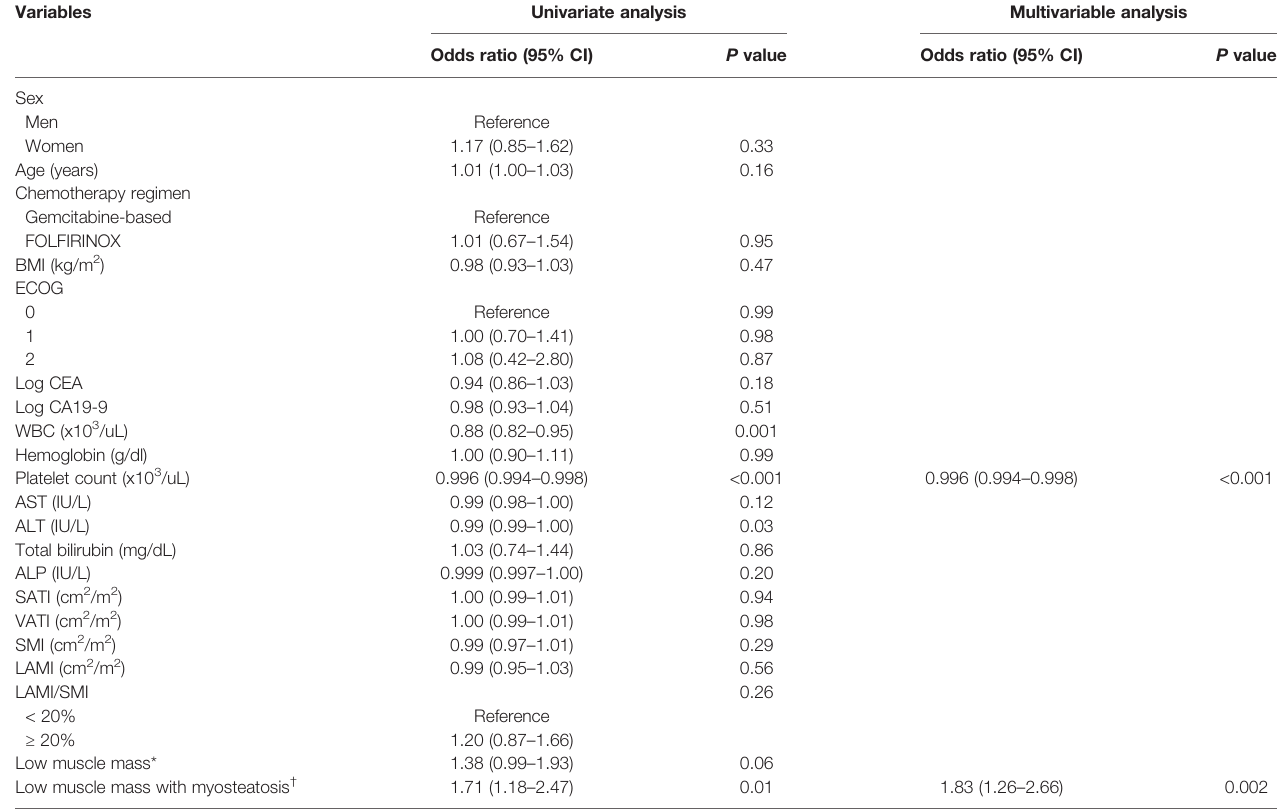
TABLE 4 | Univariate and multivariable analyses of the occurrence of treatment-modifying toxicity.